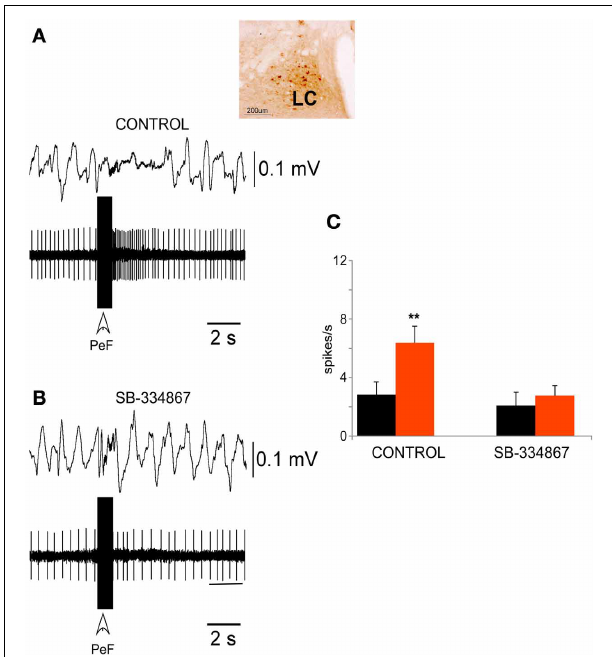
FIGURE 3 | PeFLH electrical stimulation excited LC neurons. (A) A train of electrical stimuli (50Hz; 50 μ A; 500ms of duration) in the PeFLH area (vertical arrow) evoked a long-lasting increase in LC neuronal activity and a decrease of the EEG slow waves. The inset shows the recording area, which was stained with neurobiotin. (B) This effect was blocked by the injection of the Orx-1 receptor antagonist SB-334867 into the LC by means of a Hamilton syringe (100 μ M; 100nl). (C) Plot of the mean neuronal activity measured during a 10s period before (black) and after (red) the stimulus train in the PeFLH area. In control conditions ( n = 12 cells) LC neuronal activity increased, but the effect was blocked by the Orx-1 receptor antagonist. The asterisk indicates significant statistical differences ( ∗∗ p < 0 . 01).